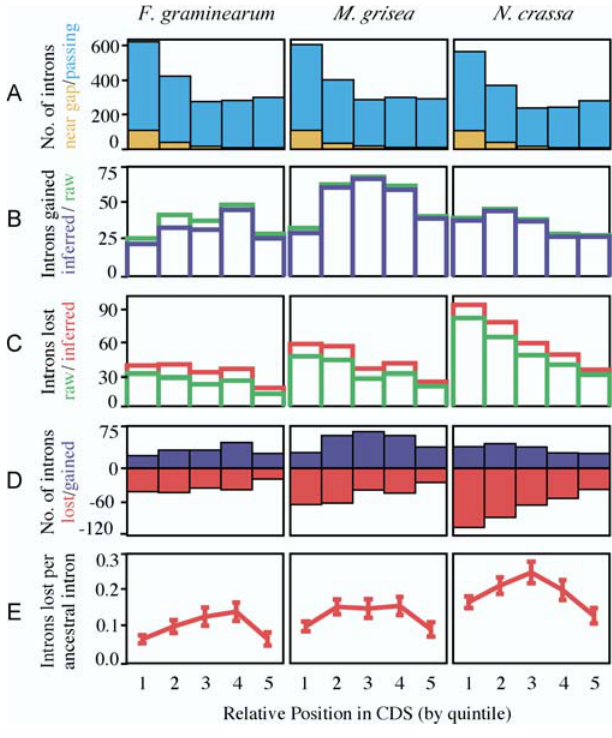
Figure 3. Positional Biases in Intron Gain and Loss Relative intron positions were defined as the number of bases in the coding sequence upstream of the intron divided by the total length of the coding sequence. These relative positions were binned into five categories (quintiles), each representing one-fifth of the coding sequence length (quintiles numbered 1–5 on the x-axis). (A) Introns passing quality filter (light blue, back) and introns adjacent to gaps in the protein alignment that were removed by our quality filter (orange, front). (B) Raw and inferred gains. Raw gains (green, back) are those introns present in exactly one organism (excluding the outgroup, A. nidulans ). Inferred gains (blue, front) are corrected for the estimated number of cases that arose by other combinations of gain and loss events. Inferred gains are thus slightly lower than raw gains. (C) Raw and inferred losses. Raw losses (green, front) are those introns absent in the organism in question but present in at least one of its siblings (descendants of its parent in the phylogenetic tree) and one of its cousins (non-descendants of its parent). Inferred losses (red, back) are corrected for the estimated number of introns lost along multiple lineages, or gained and then lost. Inferred losses are thus slightly higher than raw losses. (D) Number of introns gained (blue) and lost (red) since last common ancestor (losses shown as negative numbers). (E) Intron loss rate at each position since last common ancestor (introns lost per ancestral intron). Error bars represent binomial standard deviation. DOI: